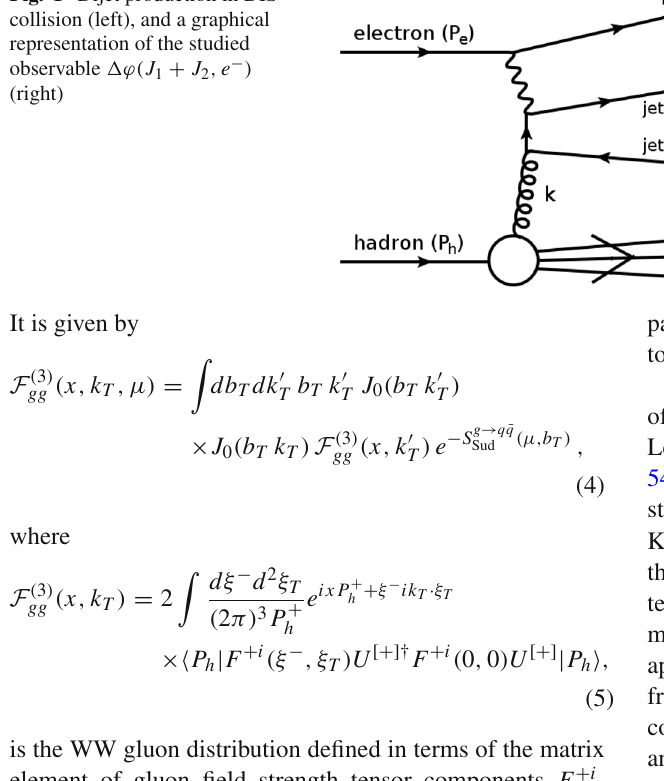
Fig. 1 Dijet production in DIS collision (left), and a graphical representation of the studied observable (cid:6)ϕ( J 1 + J 2 , e − ) (right)